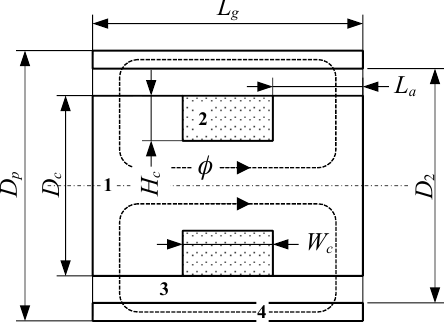
Figure 5. MR electromagnet (valve): 1—core, 2—coil, 3—annulus,